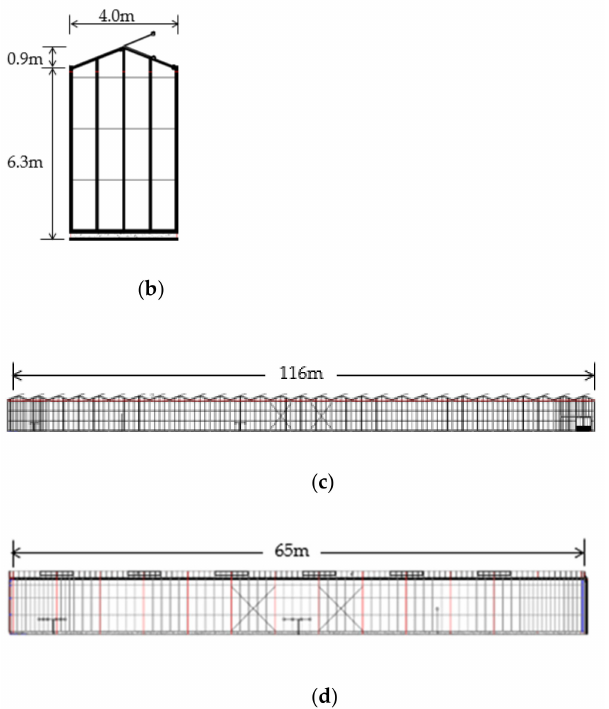
Figure 2. Schematic representation of the target greenhouse. Floor plan with air-circulation fan installed is shown in ( a ). Front, south, and east elevations are depicted in ( b – d